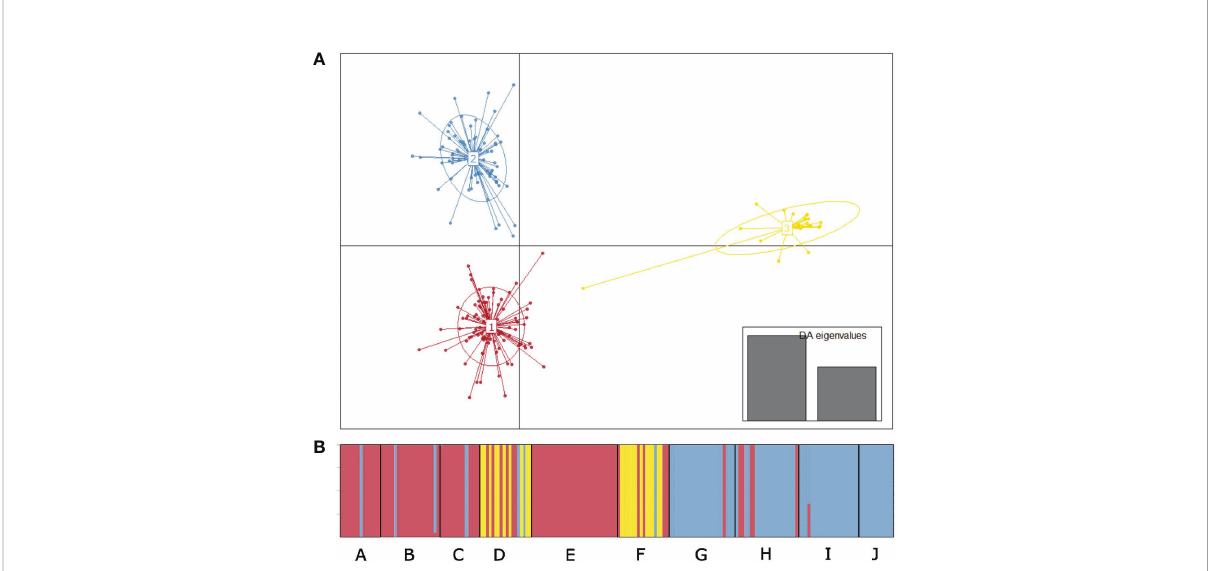
FIGURE 3 Discriminant analysis of principal components of ten Ruppia spiralis populations inferred for K = 3 populations. (A) Scatter plot describing the relationship between the clusters. Each colored circle represents a cluster and each dot represents an individual. Numbers represent the different clusters identi fi ed by the DAPC analysis. (B) Barplot showing the posterior probabilities of membership of individuals to the clusters. Populations are arranged from north to south (A – J) on the x-axis. Different colors correspond to the different clusters from the scatterplot.